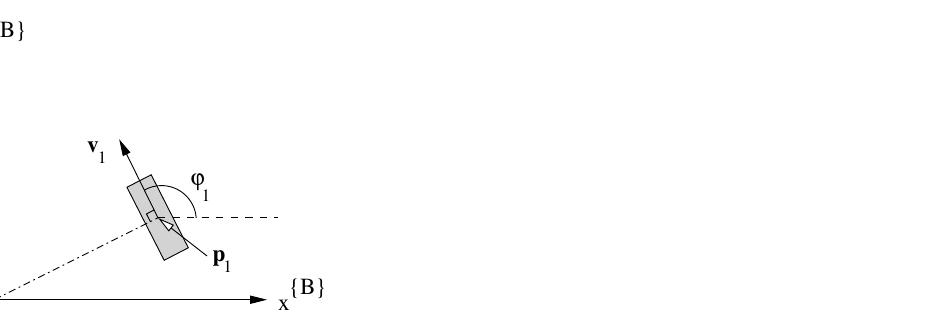
Figure 5. Wheel 1 parameters given that v = 0 , which enforces the steering wheel angle ϕ 1 to make the steering direction vector v 1 to be orthogonal towards the origin of the